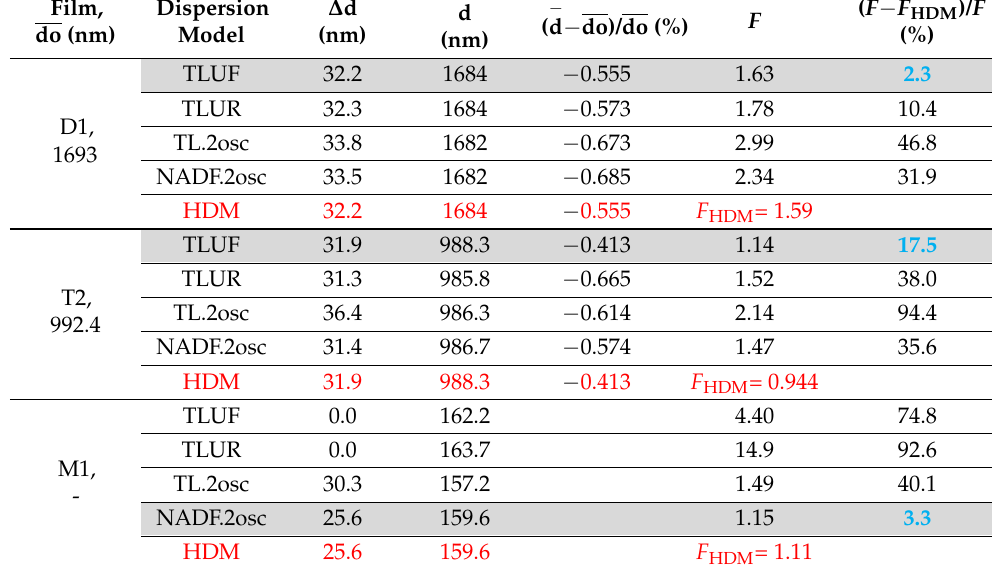
Table 3. Computed values of the thickness characteristics d and ∆ d of the PAZO polymer films and the figure of merit F for all performed characterizations. The average film thickness over the light spot derived from OEMT is denoted by “do” and the figure of merit for HDM characterization by “ F HDM ”. The quantity in the last column represents the reduction of the figure of merit F when using HDM compared to using the other four DMs. The data acquired via DM selected at stage 1 of HDM are typed on a grey background and the data regarding the entire HDM are in